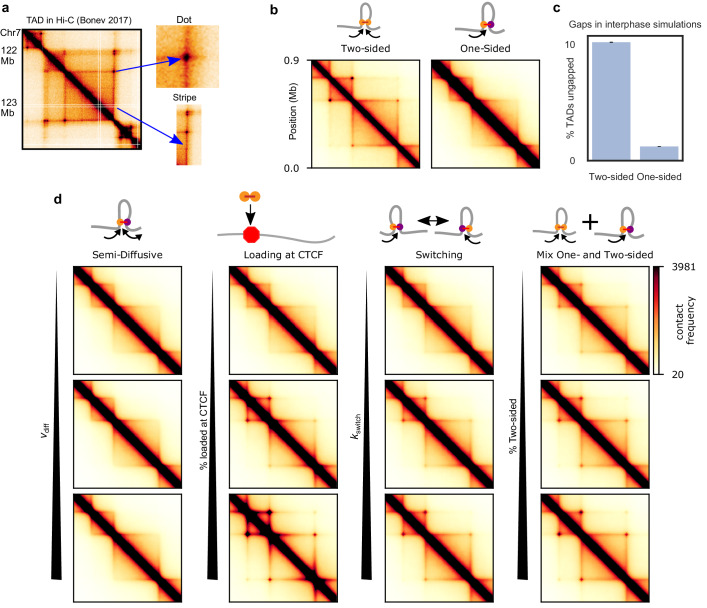
TADs and corner peaks for variations on one-sided loop extrusion.(a) A TAD in Hi-C of cortical neurons (Bonev et al., 2017), visualized by HiGlass (Kerpedjiev et al., 2018) at a resolution of 8 kb. Two characteristic features of TADs, stripes and dots, are indicated. (b) Contact maps computed from polymer simulations with two-sided (left) and one-sided (right) LEFs. The residence time and density of LEFs have been chosen to approximate the WT conditions (d=λ=200 kb) (Materials and methods and Figure 3—figure supplement 1). (c) Percentage of ungapped TADs for the same LEF separation and processivity as in (b). The percentage of ungapped TADs is computed over 100,000 LEF turnover times, for a system of 20 TADs of size 400 kb, the same size as the largest TAD in the contact maps. The standard error in the mean of the percentage of ungapped TADs is less than 0.05%. (d) Contact maps computed from polymer configurations for the semi-diffusive model, the one-sided model with biased loading, the switching model, and the model with a mix of one- and two-sided LEFs. WT values of d and λ are used for every map. The parameter values, from top to bottom and from left to right, are: vdiff/v = 0.1, 1, and 3.5 (with v = 1 kb/s, D = 0.2, 2, and 7 kb2/s), bias for loading at CTCF = 10, 100, and 1000, kswitch/kunbind = 0.1, 1, and 10 and percentage two-sided = 20, 40, and 60.